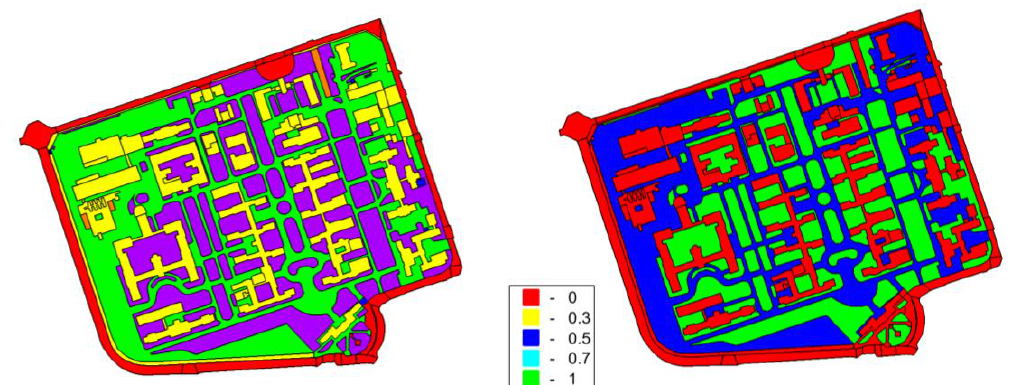
Figure 5. The original and BAF maps for test area 5